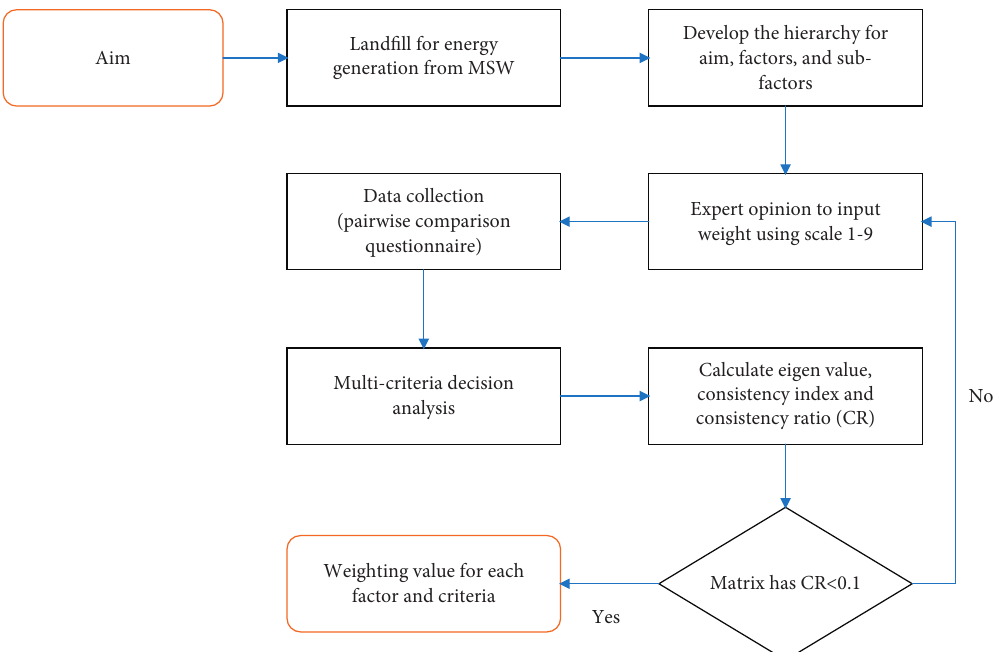
Figure 3: The flowchart to determine the factors of suitable landfill sites.